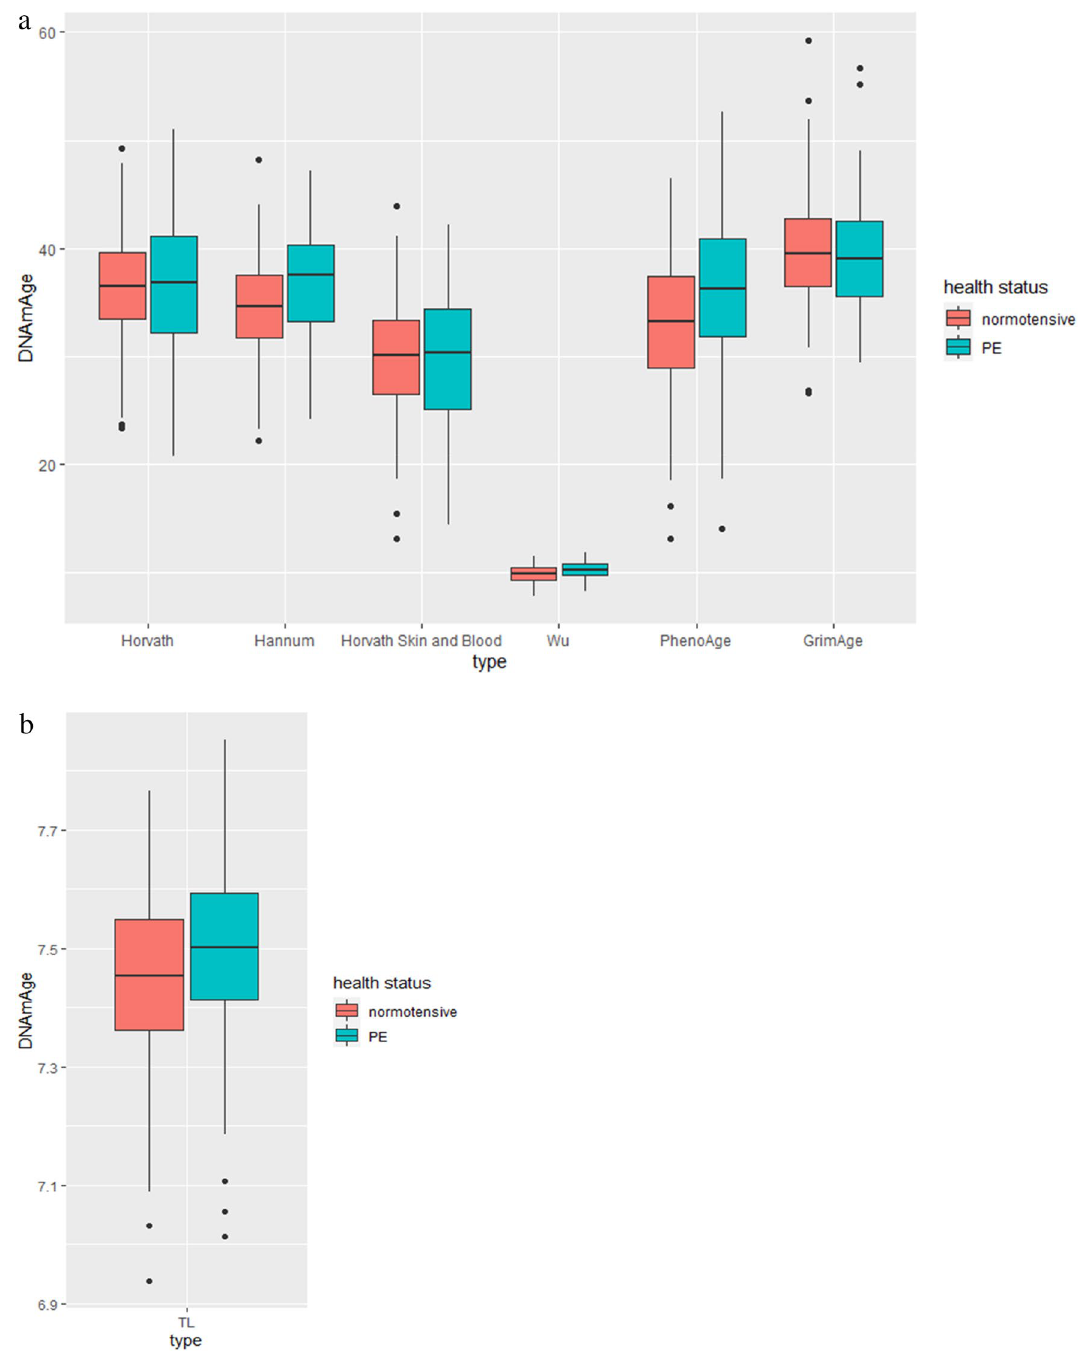
Figure 2. ( a ) Chronological age compared with six different DNAm Age models between women with normotensive and preeclamptic (PE) pregnancies. ( b ). Measure of TL DNAmAge between women with normotensive and preeclamptic (PE)